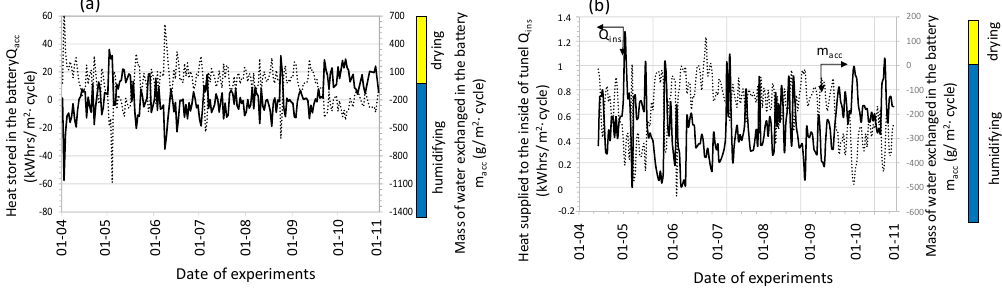
Figure 14. Changes in heat and mass during charge ( a ) and discharge ( b ) cycles.